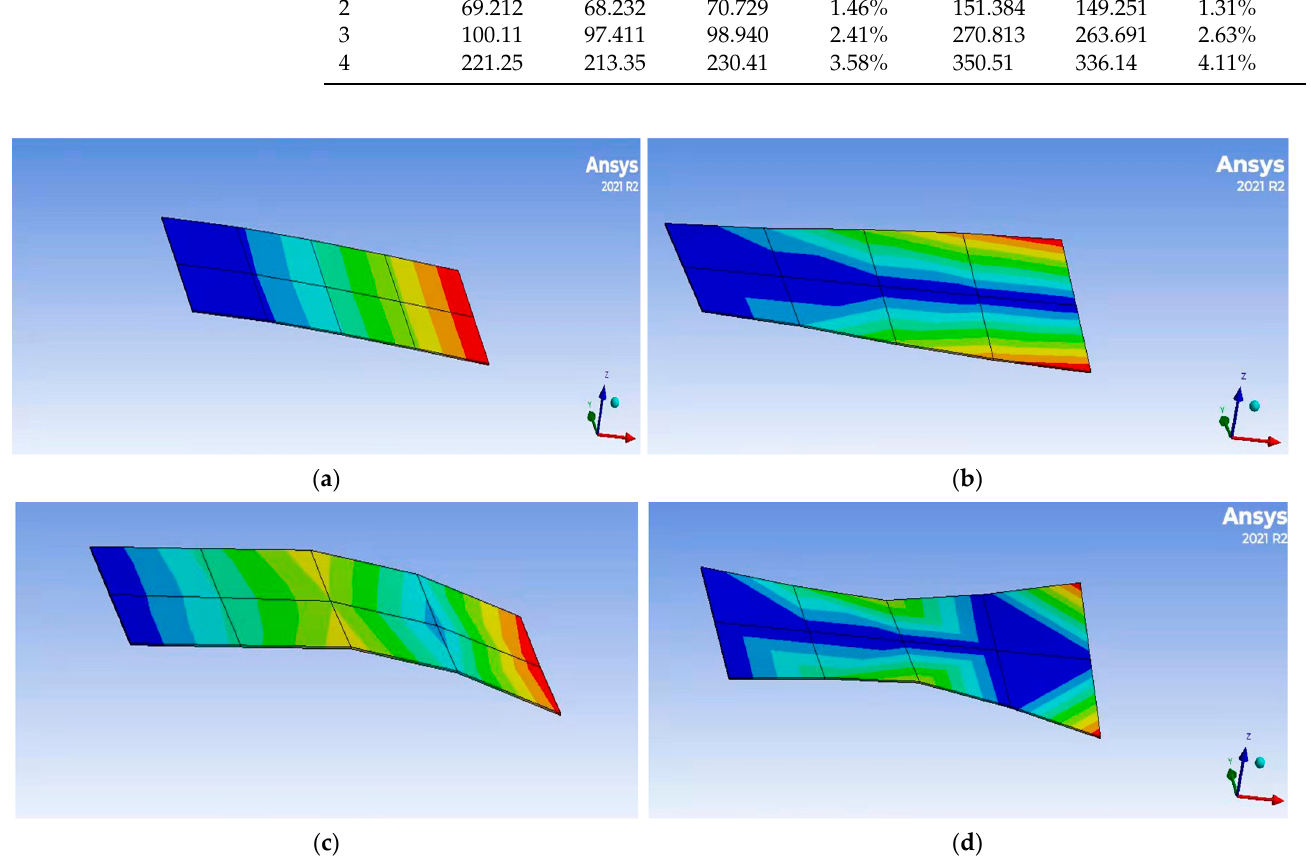
Figure 7. The first four modal shapes of cantilever plate (Ansys solution) . ( a ) First-order bending mode; ( b ) second-order torsional mode; ( c ) third-order bending mode; ( d ) fourth-order torsional mode.